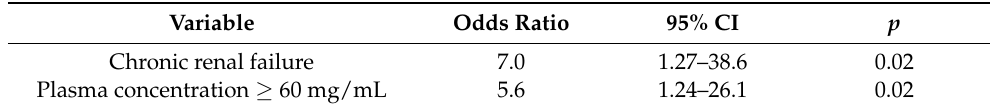
Table 5. Logistic regression analysis of independent risk factors associated with occurrence of cefepime-induced